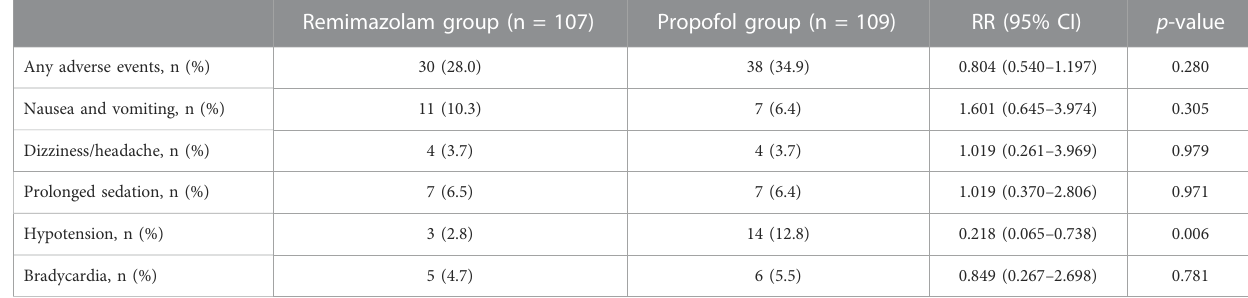
TABLE 4 Incidence of adverse